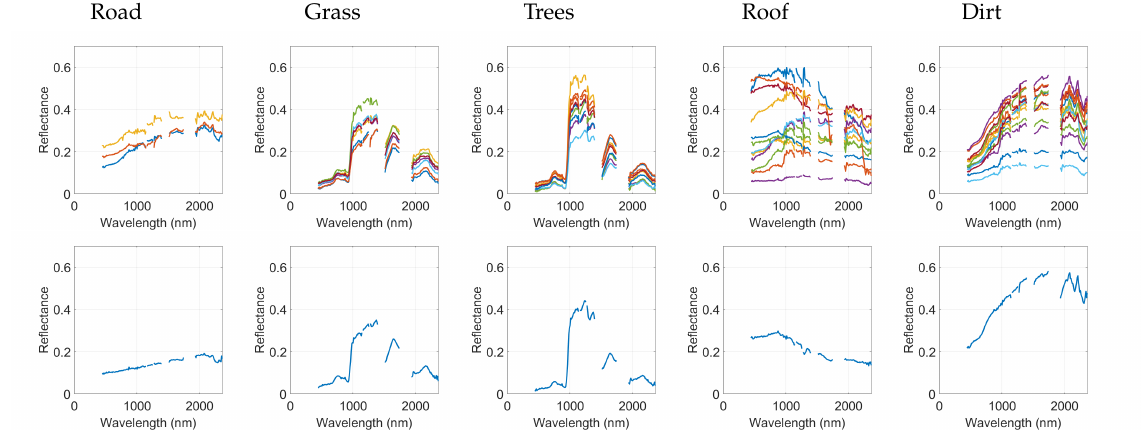
Figure 18. Comparison of the information classes spectral endmembers extracted with the proposed algorithm and reference endmember spectral signatures. Top row: the results of the proposed approach; Second row: reference